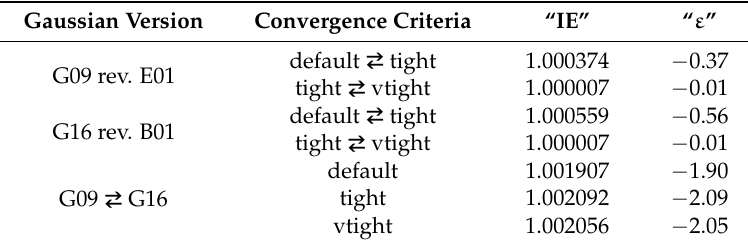
Table 1. The influence of the convergence threshold and version of the program on the error of isotope effect calculations.